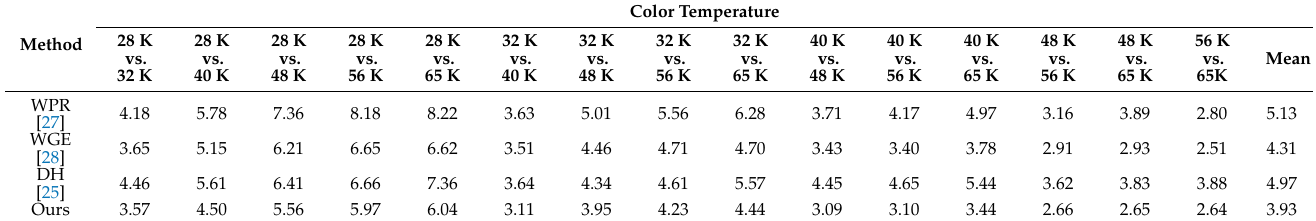
Method Table 3. The results of CIEDE2000 among WPR [27], WGE [28], DH [25], and our methods.